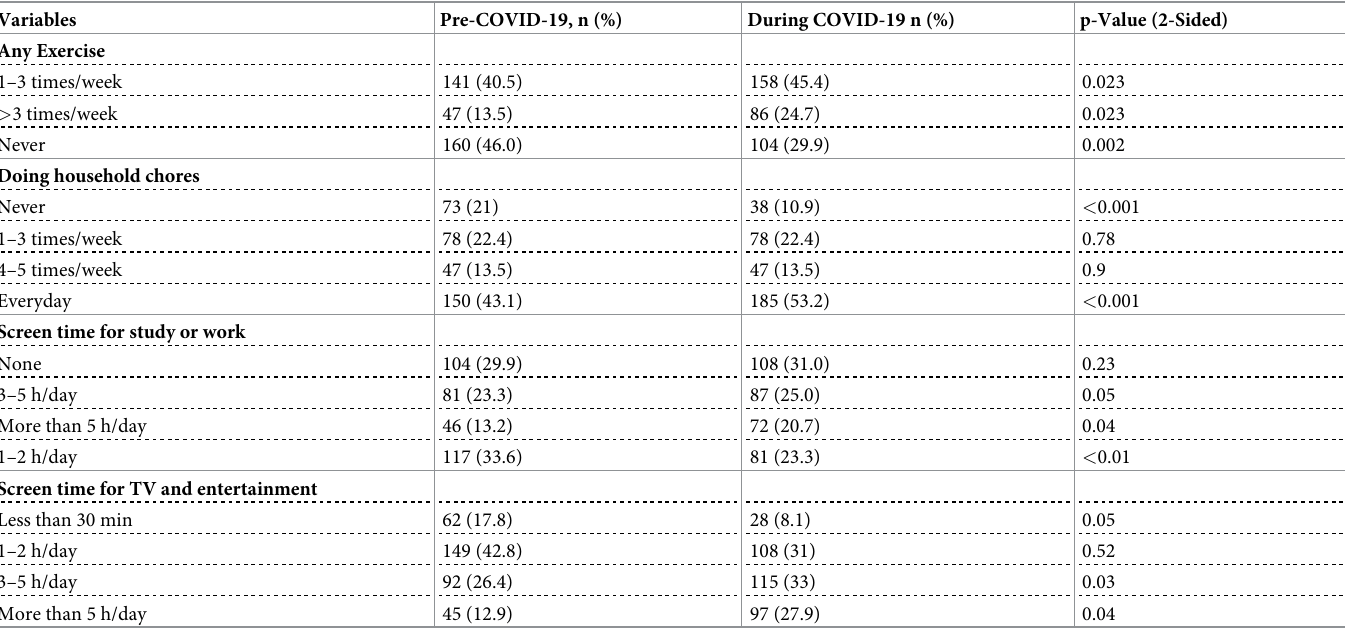
Table 6. Daily activities pre-and during COVID-19 pandemic (n = 348).